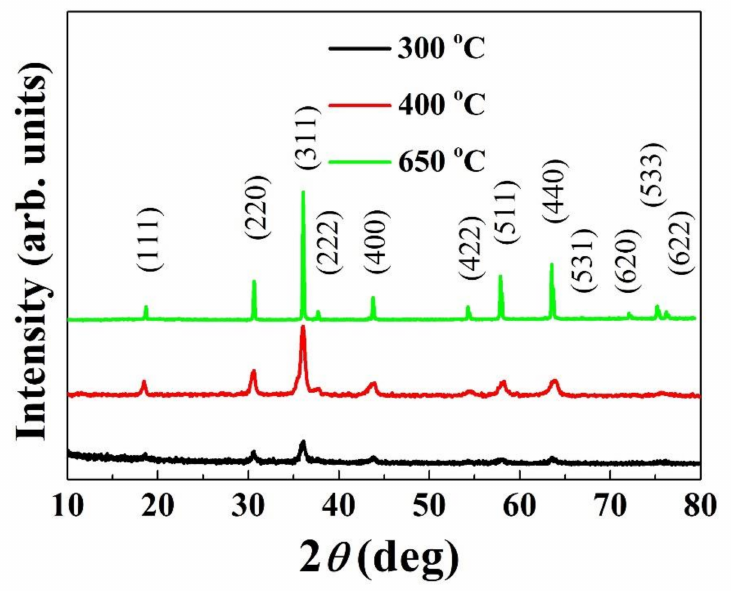
Figure 2. XRD patterns of oxide powder calcined at different temperatures.